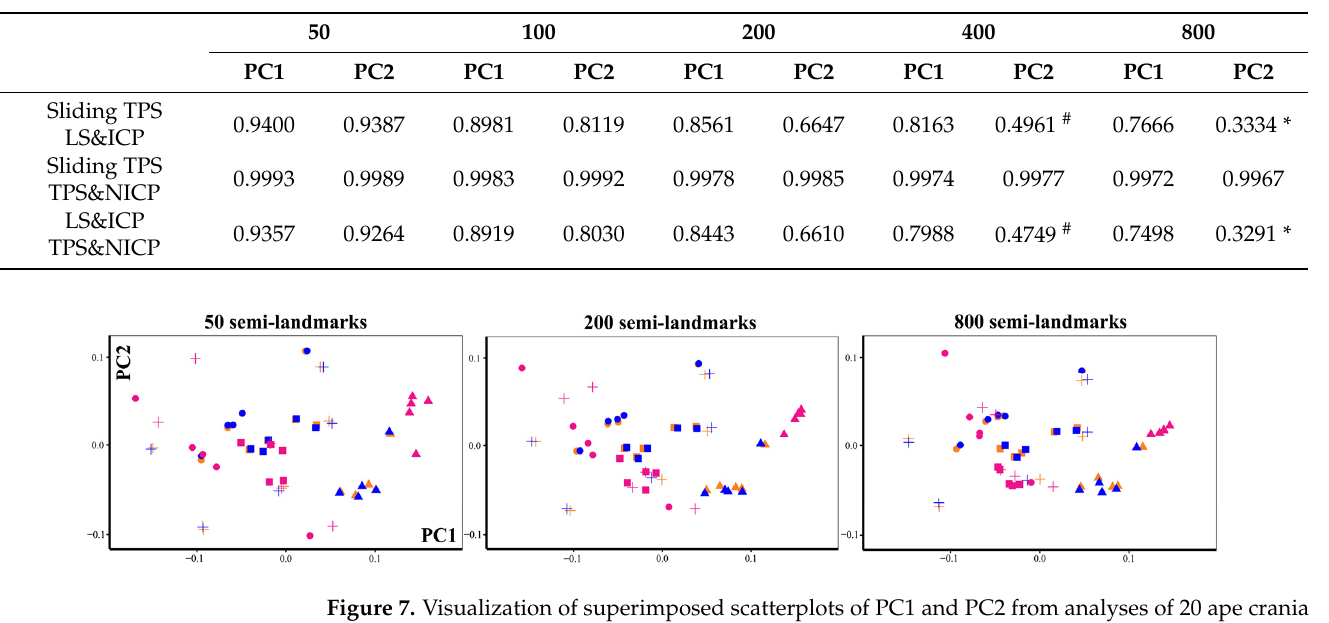
Table 7. Comparison of Pearson correlations (all p < 0.01, except # , p < 0.05, * = n.s.) of PC1 and PC2 between sliding TPS and TPS&NICP.